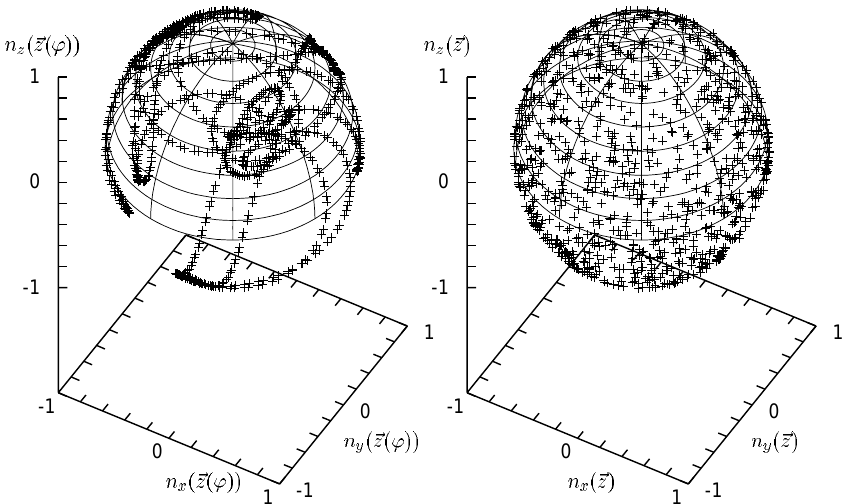
FIG. 8. Invariant curves of spin-orbit motion on the unit sphere for a beam in HERA with normalized vertical emittance of 64 p mm mrad and no horizontal emittance (left) and with an additional normalized horizontal emittance of 4 p mm mrad